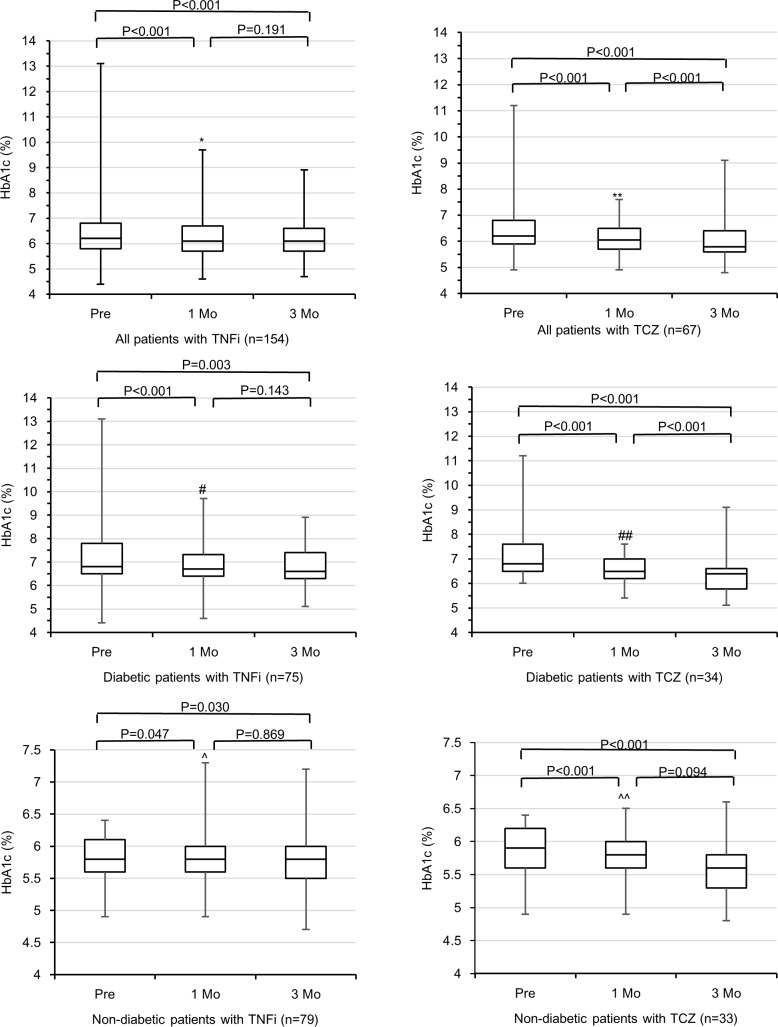
Effects of TNF inhibitors (TNFi) and tocilizumab (TCZ) on glycosylated hemoglobin (HbA1c) in 1 month and 3 months after initiation of biologic agents.Boxes indicate interquartile range and horizontal bars represent median values. Whiskers indicate most extreme points. Changes in HbA1c were evaluated by the Friedman test, which were significant in all the six groups (p<0.001). Subsequently, each HbA1c values were compared by the Wilcoxon signed rank test. The significance level was adjusted as 0.017 by Bonferroni method. *Number of missing value is 25. ** Number of missing value is 13. # Number of missing value is 13. ## Number of missing value is 7. ^ Number of missing value is 12. ^^ Number of missing value is 6.